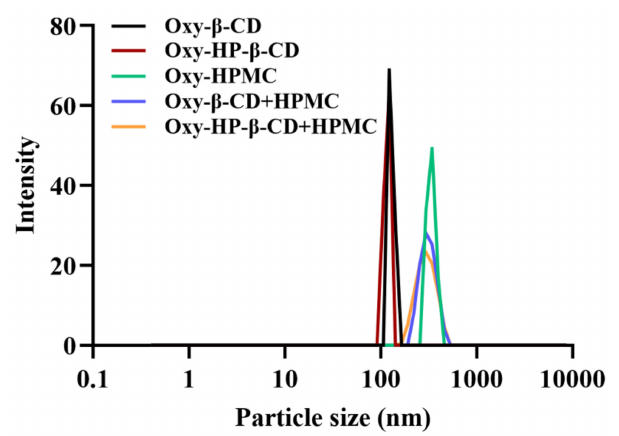
Figure 4. Intensity particle size distribution of Oxy–CD, Oxy–HPMC, and Oxy–CD–HPMC solution at the Oxy concentration of 1mM were measured on a Zetasizer Nano ZS.